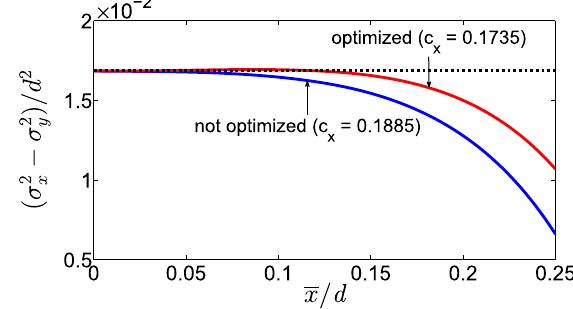
FIG. 6. ð σ 2 x − σ 2 y Þ =d 2 as a function of ¯ x=d for a not and an optimized factor c x ; c y ¼ 0 . 1885 .